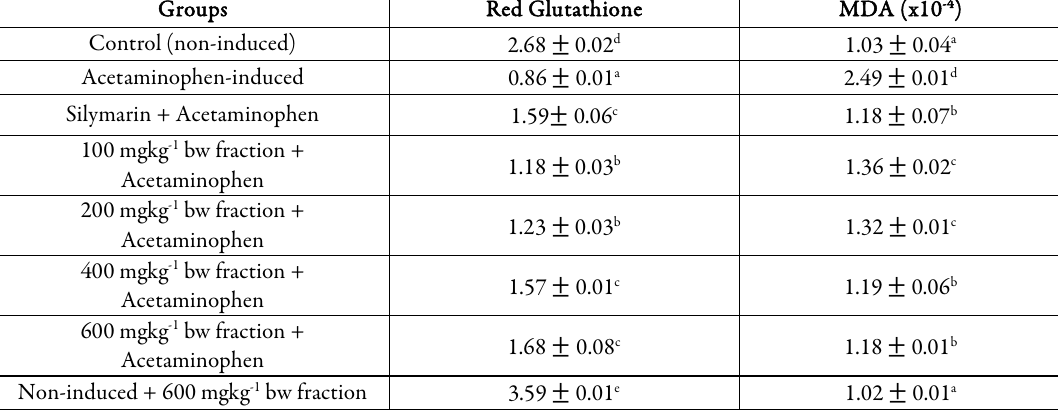
Table 7. Levels of reduced glutathione (nmol/mmg protein) and malondialdehyde (mmol/mg protein) liver of the rats